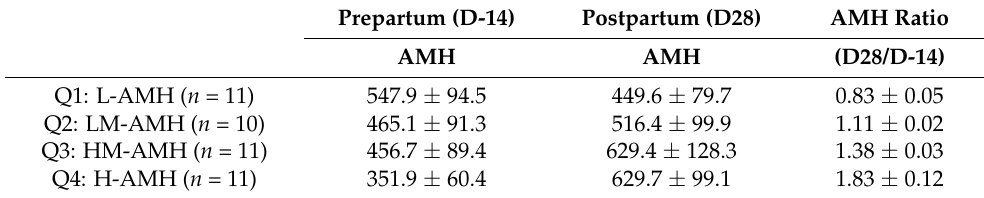
Table 3. Results of body condition score (BCS), rumen fill score (RFS), and serum biochemical analyses (mean ± SEM) of H ‐ and L ‐ AMH cows at pre ‐ (D ‐ 14) and postpartum (D28) periods.